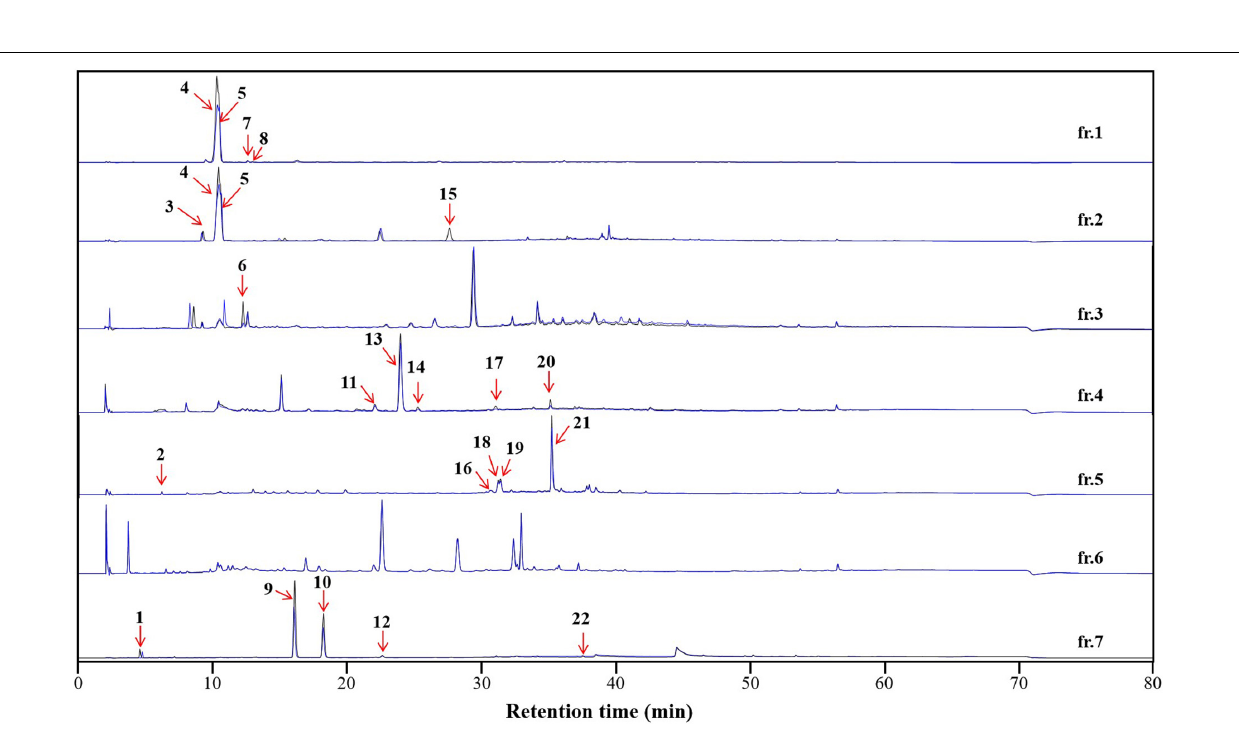
FIGURE 7 | The affinity-based ultrafiltration chromatograms of the high-speed counter-current chromatography (HSCCC) fractions of the Dryopteris crassirhizoma rhizome (DCR) extract. The blue and black lines indicate fractions incubated with and without tyrosinase, respectively. The numbered peaks correspond to tyrosinase